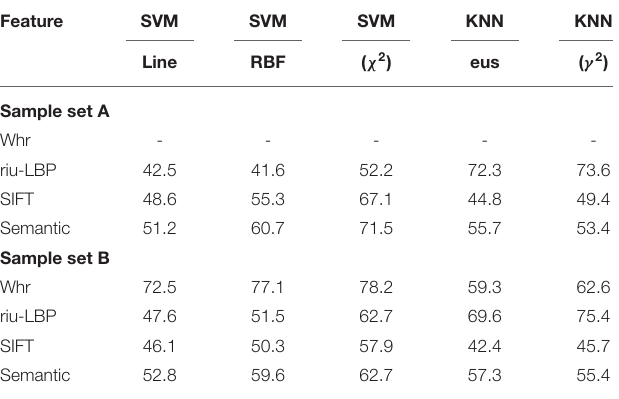
TABLE 2 | Experiments on single feature extraction/%.